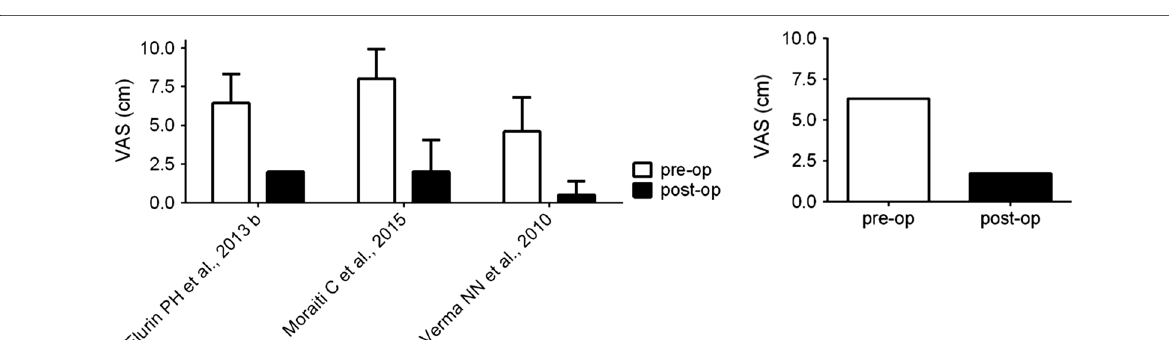
Fig. 3 Comparison of VAS in pre- and postoperative populations. Left: mean VAS values reported in the analyzed studies; Right: weighted average value of VAS. VAS, visual analog scale; pre-op, preoperative; post-op, postoperative